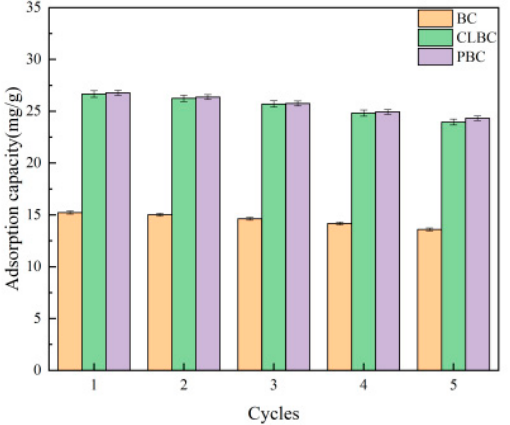
Figure 8. Adsorption–desorption cycles for SMX on BC, ClBC and PBC.